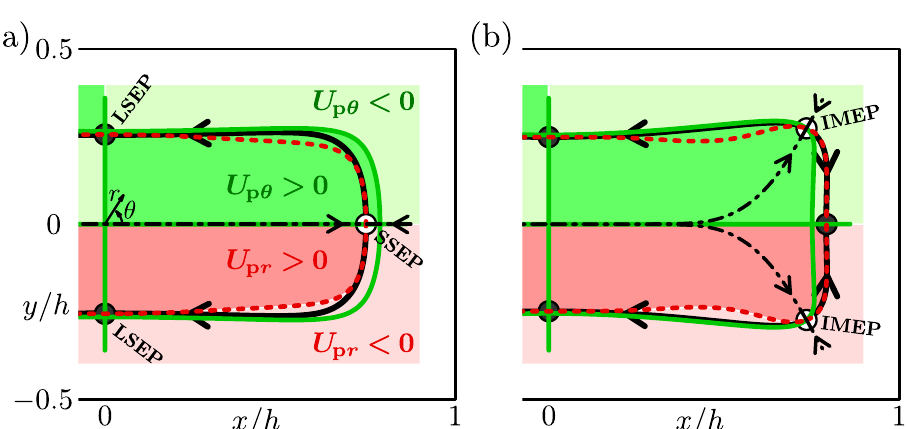
Figure 4. Nullclines of the lateral trajectories of a suspended particle. The red dashed curves represent the zero-level set contour for the radial component of the particle velocity in the cross-section ( r -nullcline). The green solid curves and lines aligned with the axes are the contours of U p θ = 0 ( θ -nullcline). Filled and open circles correspond to stable and saddle equilibrium points, respectively. Equilibrium points in ( a ) are the long side equilibrium point (LSEP) and the short side equilibrium point (SSEP), and those in ( b ) are the LSEP, the SSEP, and the intermediate equilibrium point (IMEP). Thick curves with arrows are the particle trajectories and correspond to the pSS ring. Dash-dotted curves represent the separatrices. The regions classified by the sign of U p r are drawn in y < 0, whereas the regions in terms of U p θ are in y > 0. U p r > 0: red, U p r < 0: light red, U p θ > 0: green, and U p θ < 0: light green. A = 2, d / h = 0.2. ( a ) Re = 50, ( b ) Re =